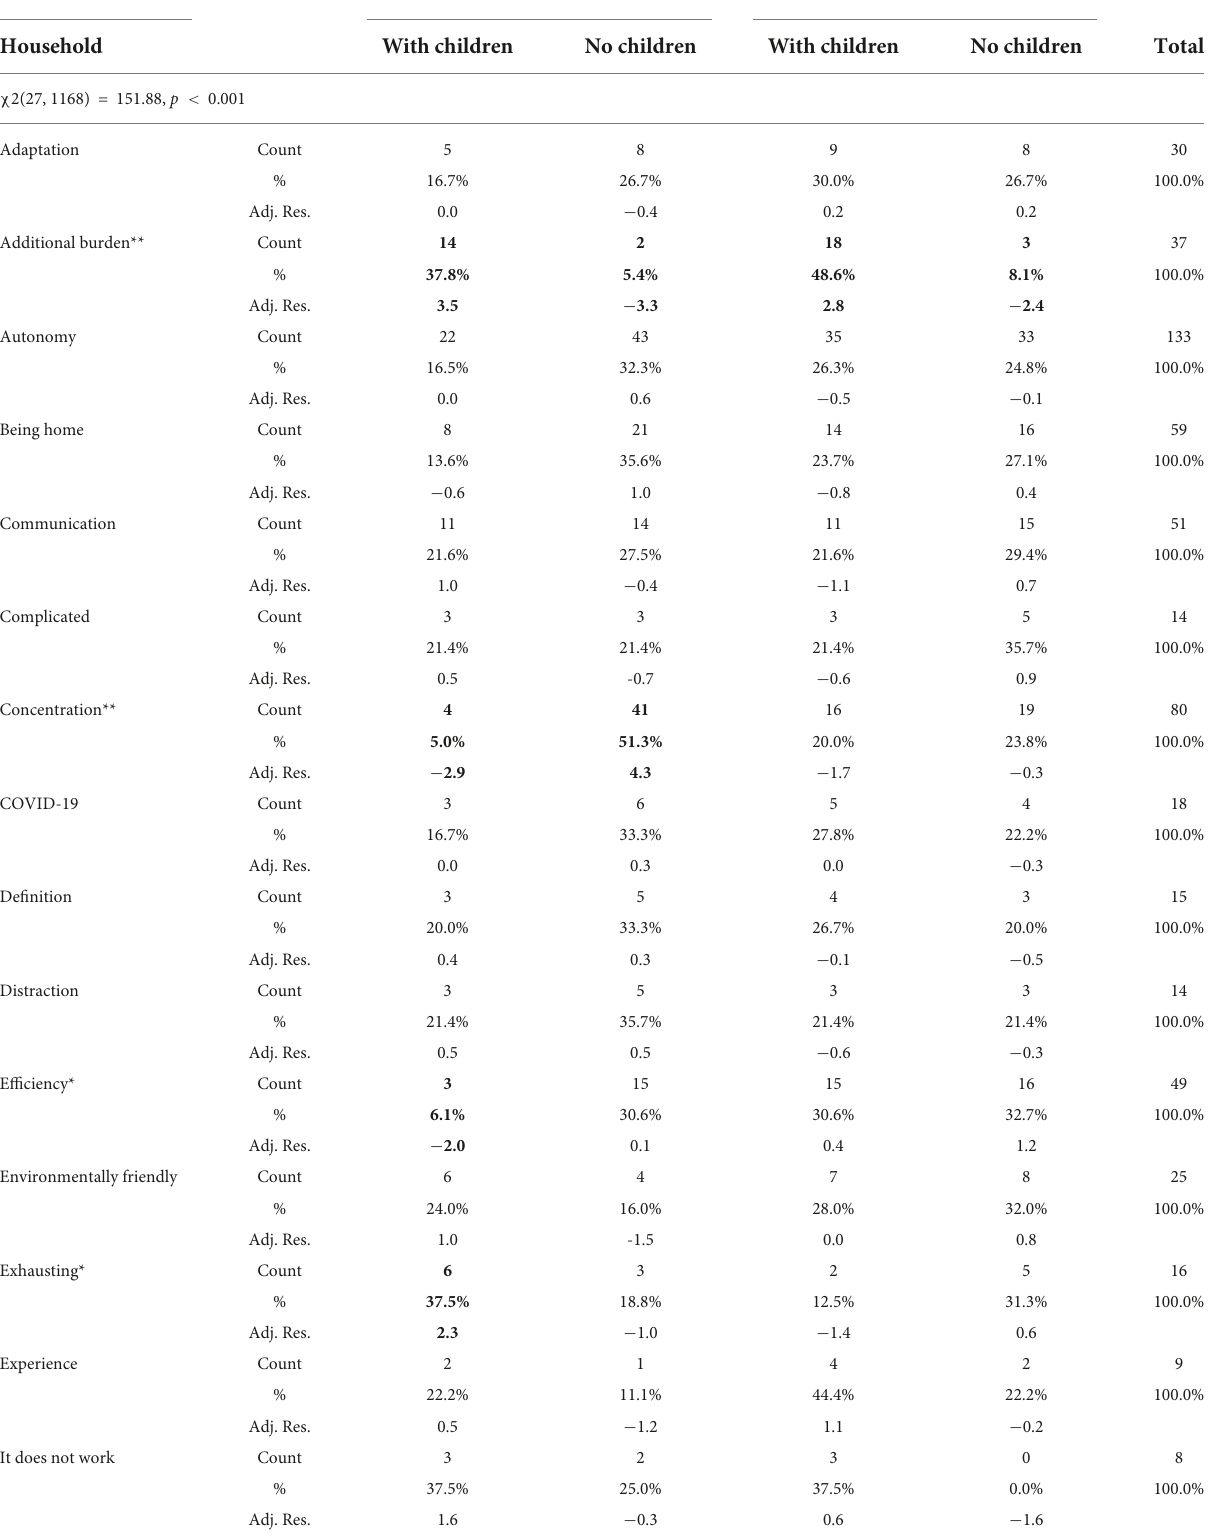
TABLE 3 Contingency table with semantic categories. Gender Women Men Household With children No children With children No children Total χ 2(27, 1168) = 151.88, p <